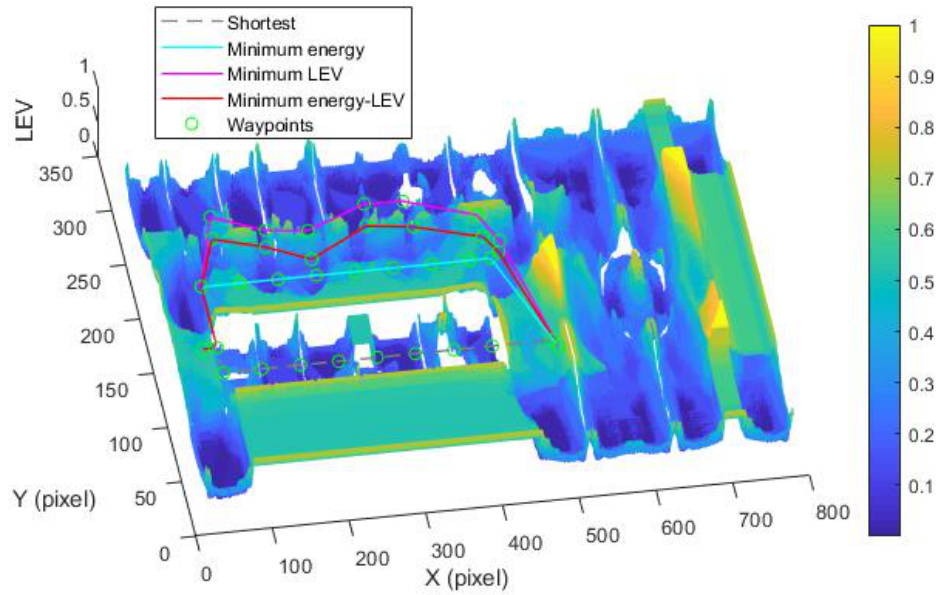
Figure 12. Comparison of trajectories of the case (2).